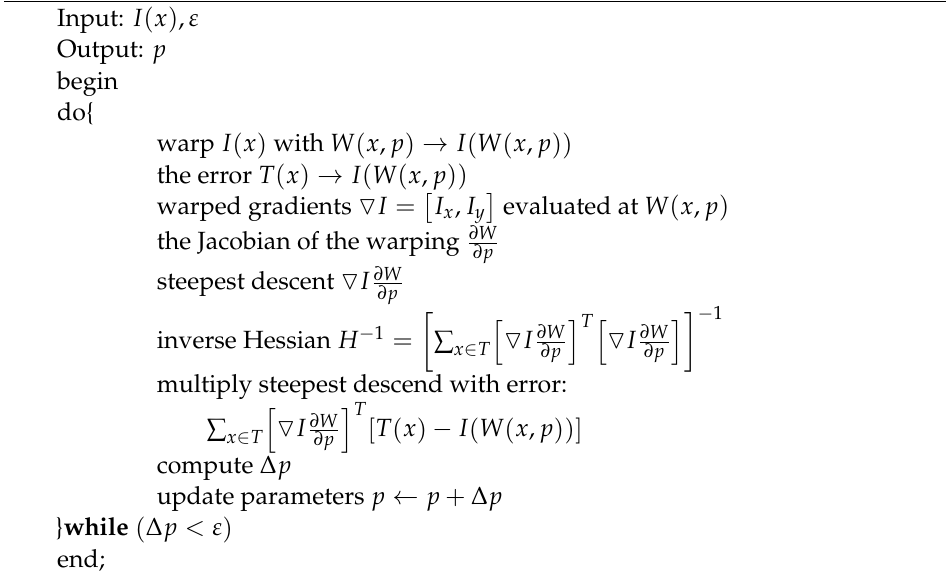
Algorithm 1 Image characteristic point detector tracker–KLT